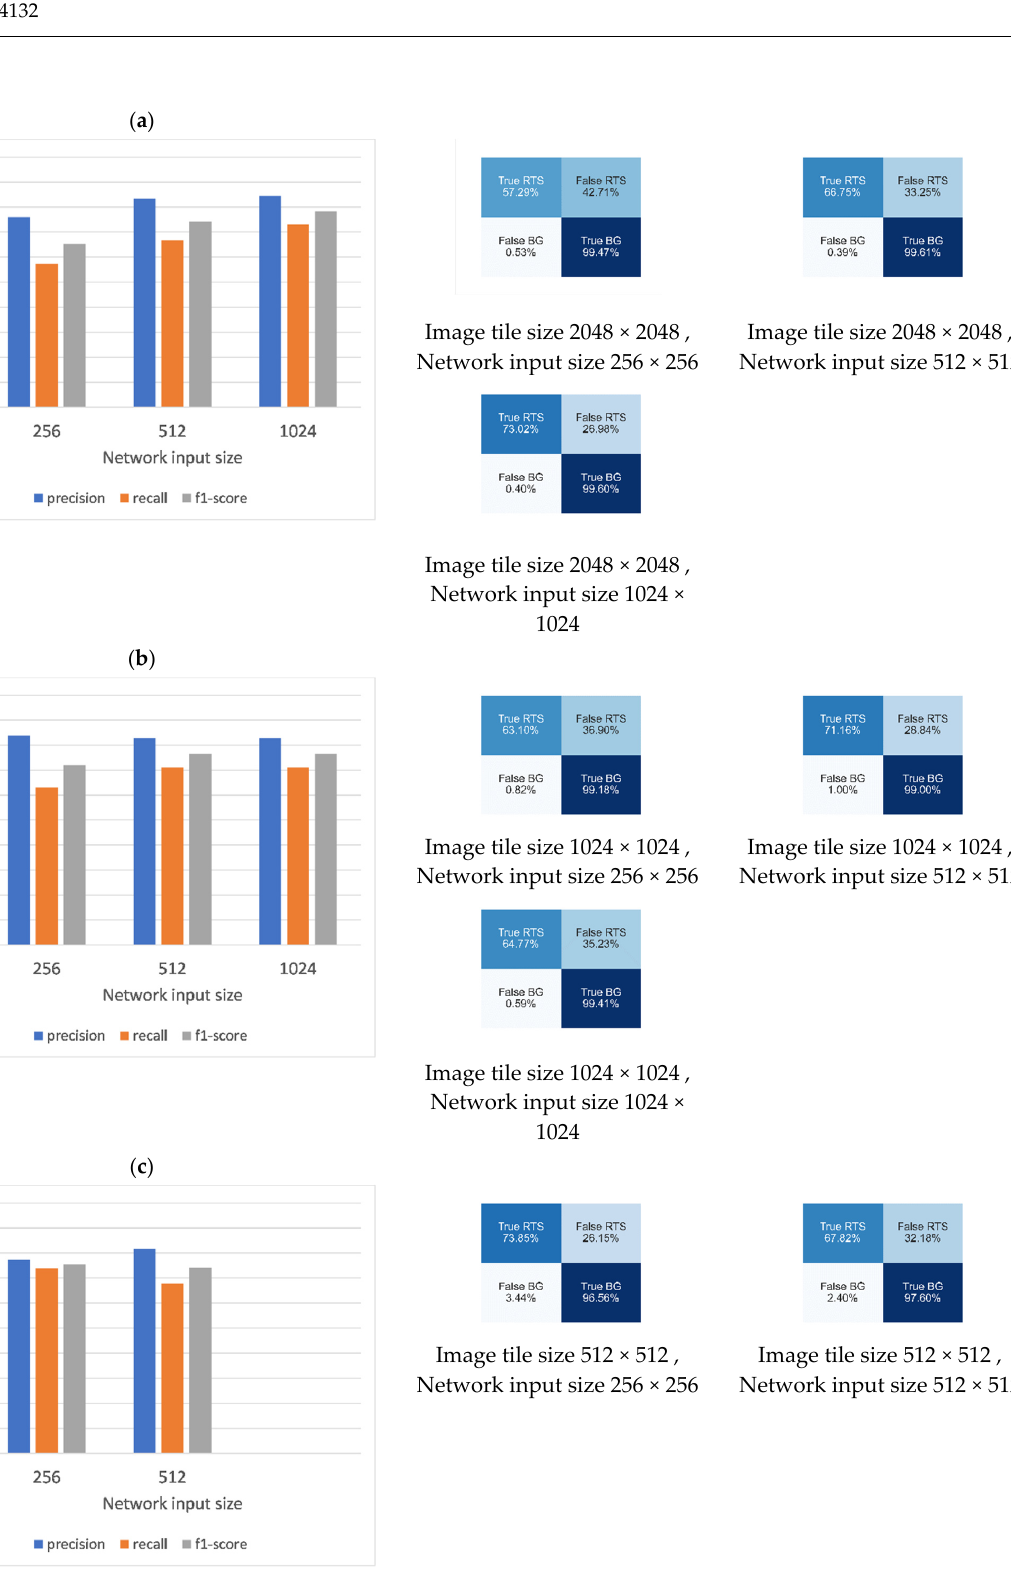
Figure 13. Model test accuracy based on the hand-annotated RTS from the Eureka Sound Lowlands. ( a ) Image tile size of 2048 × 2048 resized to network input sizes of 256 × 256, 512 × 512, and 1024 × 1024. ( b ) Image tile size of 1024 × 1024 resized to network input sizes of 256 × 256, 512 × 512, and without resizing as 1024 × 1024. ( c ) Image tile size of 512 × 512 resized to network input size of 256 × 256 and without resizing as 512 × 512. Bar charts depict accuracy measures of Precision, recall, and F1 score. Corresponding confusion matrix for each of the scenarios shown on the